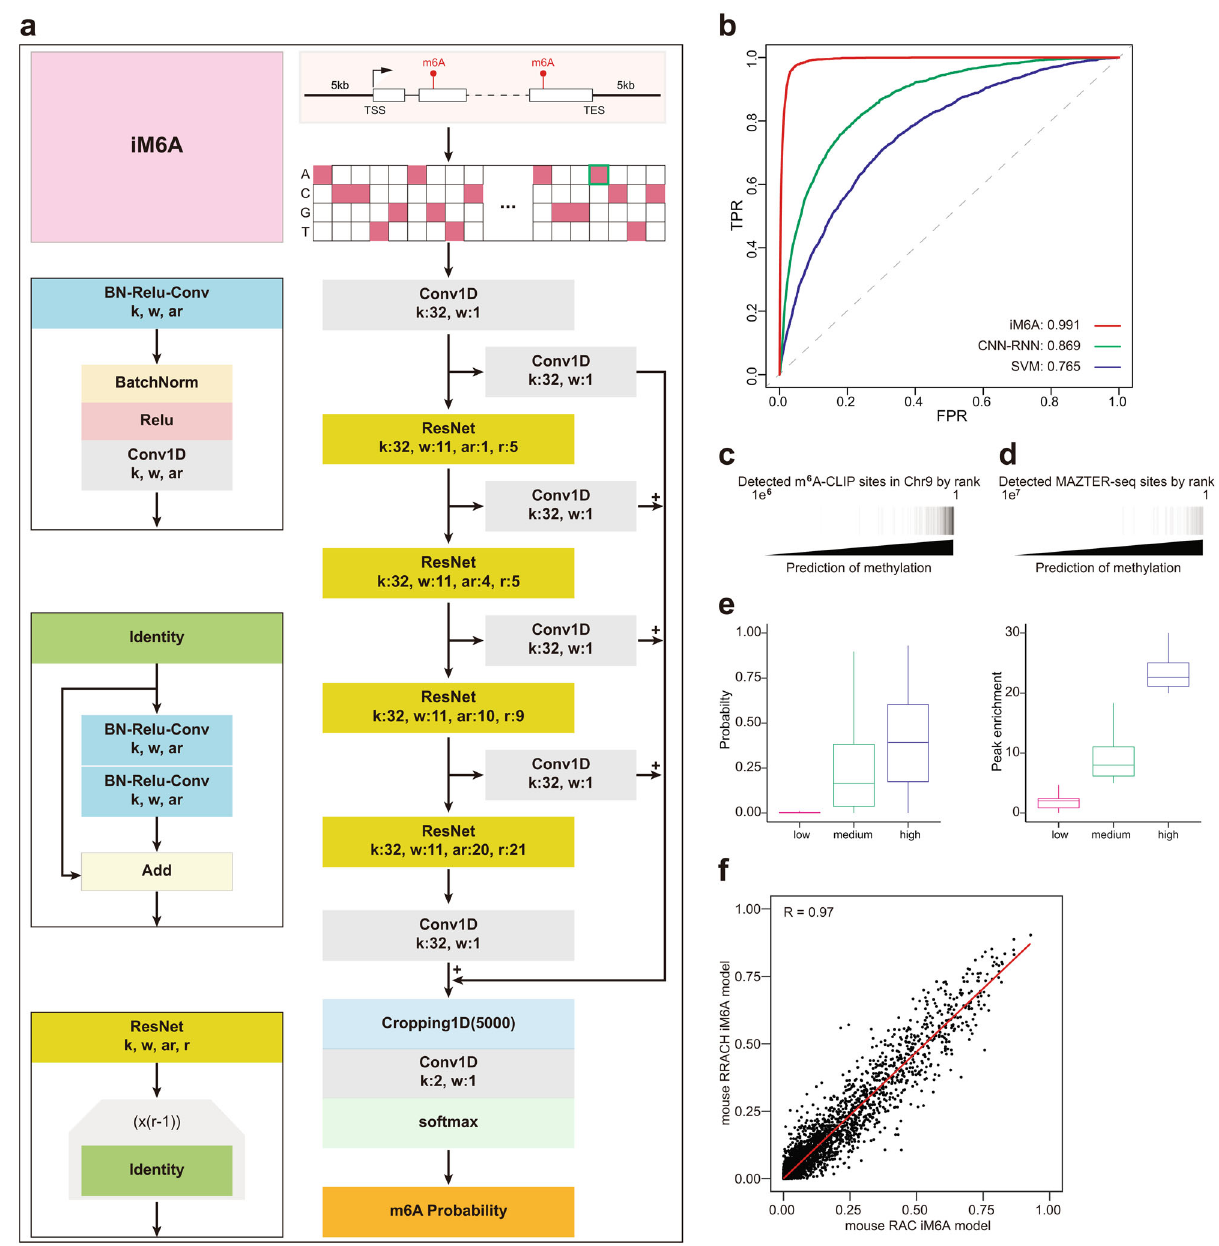
Fig. 1 iM6A models m 6 A deposition with single-nucleotide resolution. a iM6A architecture. The architecture started with a convolutional layer (Conv), then was followed by four Residual Network (ResNet) blocks, where k, w, ar, and r are the number of convolutional kernels, window size, dilation rate of each convolutional kernel in the layer, and repetition numbers respectively. Further, the output of every ResNet block was added to the input of penultimate layer, connected with a convolutional unit with softmax activation. b Receiver operator curves (ROCs) and corresponding area under receiver operator curves (AUROC) scores of iM6A, CNN-RNN (implemented in TDm6A 40 ), and SVM (implemented in MethyRNA 43 ). Here mouse chromosome 9 data was used to test the iM6A, CNN-RNN, and SVM models, which were trained independently on data of other mouse chromosomes except chromosome 9 (similar result was obtained for human m 6 A modeling in Supplementary Fig. 1a). c Heatmap of the iM6A modeling and m 6 A-CLIP detected sites in mouse chromosome 9. The modeled sites were sorted based on modeled score, the black line denoted whether methylation was identi fi ed at the sites by m 6 A-CLIP 14,33 . d Heatmap of the iM6A modeling and MAZTER-seq detected sites. The modeled sites (conformed to RRACA) were sorted based on modeled score, and the black line denoted whether methylation was identi fi ed at the sites by MAZTER-seq 34 . e The modeled probability by iM6A agreed with the experimentally quanti fi ed m 6 A methylation level. Modeled probability by iM6A (left panel) and enrichment score quanti fi ed by m 6 A-CLIP (right panel) at mouse m 6 A sites. The m 6 A sites were categorized into three groups based on their m 6 A peak enrichment value as the low ( n = 63,0854), medium ( n = 76,111), and high ( n = 3229) groups. Median and interquartile ranges are presented for the box plot. f Scatter plot of modeled probability for m 6 A sites ( n = 100,000) in mouse chromosome 9 using mouse RAC iM6A model versus mouse RRACH iM6A model. Each dot represented one site in mouse chromosome 9 discovered by both models, and the labeled axes provided the probability values for that site by the two models.